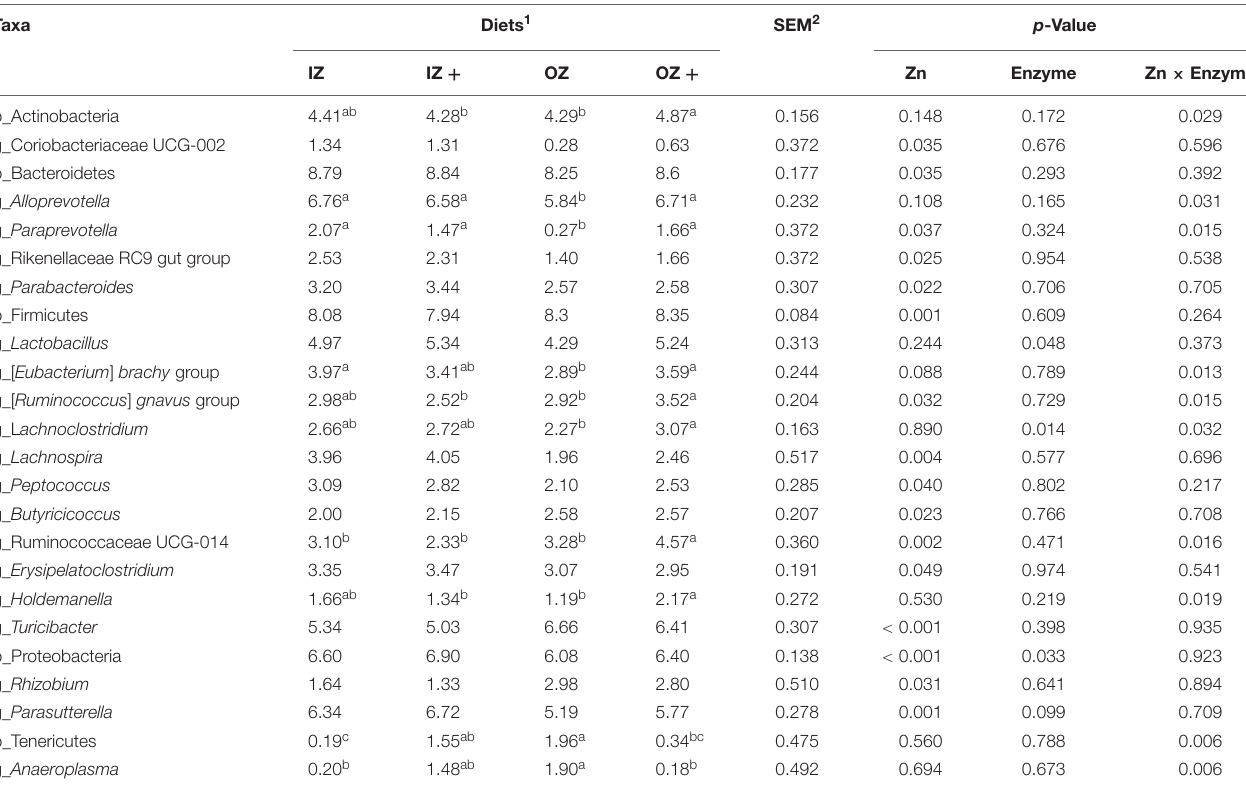
TABLE 3 | Most abundant bacterial genera ( − log copies) in each phylum extracted from feces of dogs fed diets supplemented with inorganic (IZ and IZ + ) and organic (OZ and OZ + ) Zn sources without (IZ and OZ) and with (IZ + and OZ + ) the addition of a multi-enzymatic complex from the solid-state fermentation of Aspergillus niger. Taxa Diets 1 SEM